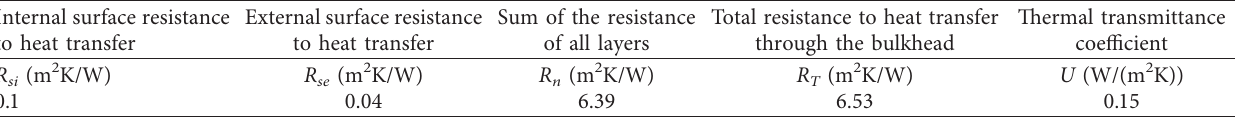
Table 5: Thermal transmittance coefficient—intensive green roof (the table is structured by authors upon data from cost estimate and